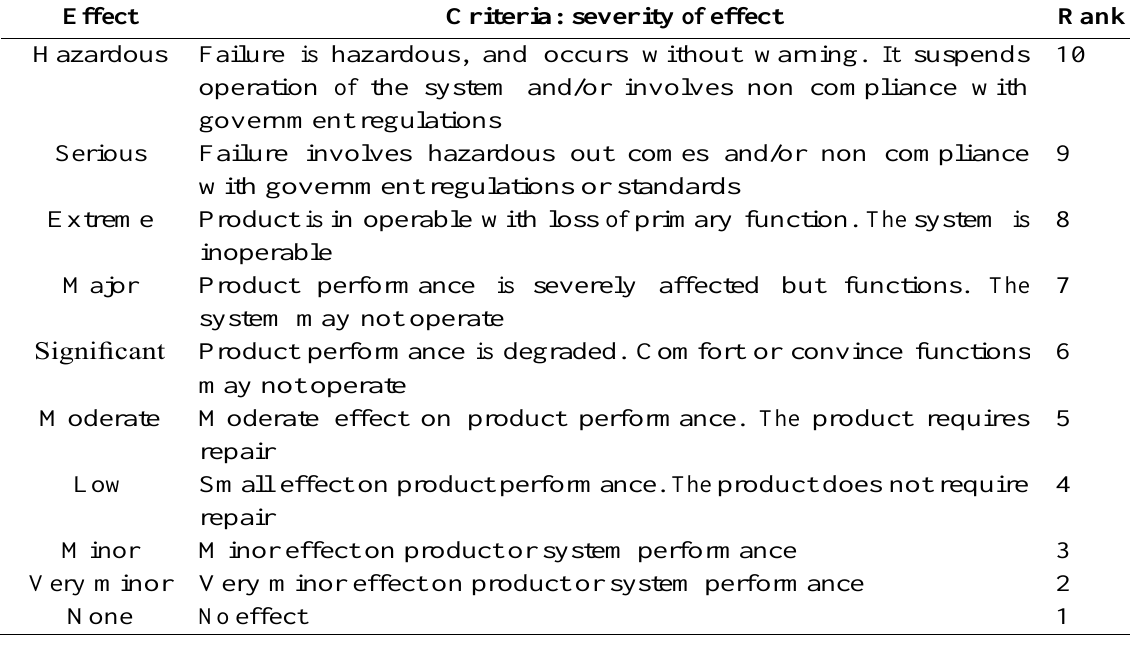
Table 2. Crisp rating for severity of a failure Criteria: severity of effect